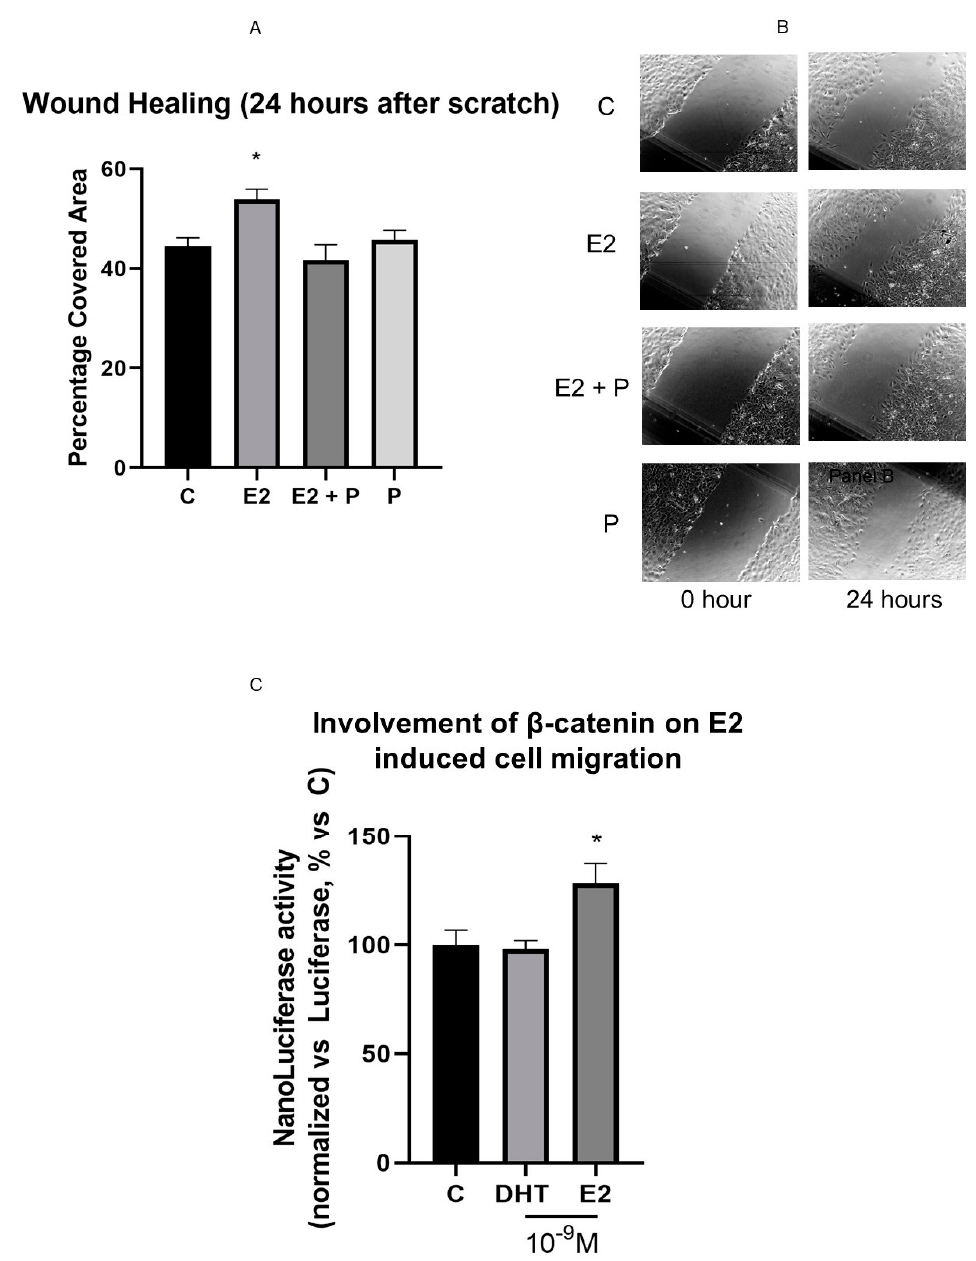
Figure 9. Involvement of β -catenin pathway in steroid-promoted migration. Panel ( A ): Procaine, a Wnt/ β -catenin signaling pathway inhibitor, removed the wound-healing effects of E2 (10 − 9 M) in MC3T3-E1 cells. Cells were incubated with procaine (2 µ M) 30 min before E2. ( A ): quantification of wound closure. The graph represents the wound width as the percentage of the closure of the original wound. The area of the wound size was detected using ImageJ Software. ( B ): pictures of representative microscope fields of wound closure. The involvement of the β -catenin pathway was evident in steroid-promoted migration. The data are presented as the mean ± SEM of eight replicates within a single experiment. The experiment was repeated twice. * p < 0.05 vs. control. ( C ): role of E2 in inducing β -catenin transcriptional activity. MC3T3-E1 cells were transiently co-transfected with pGL4.54 (luc2TK) pNL (NLucP/TCF-LEF-RE) and treated for 48 h with steroids (10 − 9 M). The level of β -catenin promoter transactivation is expressed as a percentage, i.e., ratio between nanoluciferase and firefly luciferase activity. We represented the data as the mean ± SEM of eight replicates. Differences between groups were evaluated by one-way ANOVA, followed by Bonferroni post-hoc test * p < 0.05 vs.